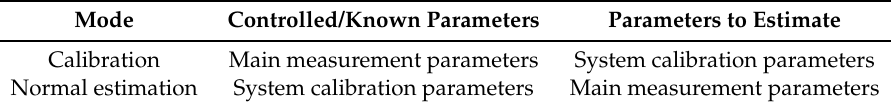
Table 7. Example of use-case